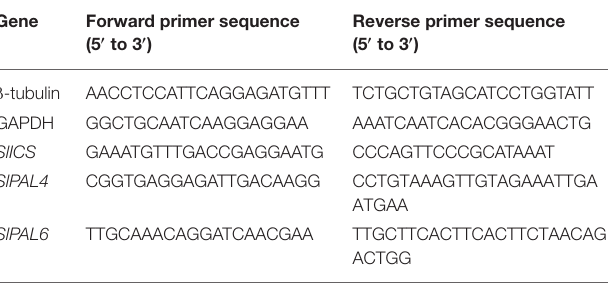
TABLE 1 | Primers used in RT-qPCR gene expression analysis. Gene Forward primer sequence (5 ′ to 3 ′